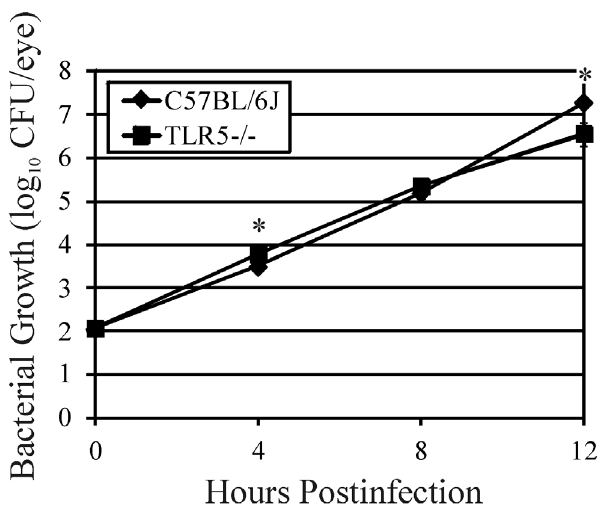
Figure 1. Influence of TLR5 on bacterial growth during experimental B.cereus endophthalmitis. C57BL/6J wild type and TLR5 2 / 2 mouse eyes were injected with 100 CFU B. cereus . Eyes were harvested, homogenized, and analyzed for bacterial growth. Overall, B. cereus grew to similar concentrations in infected eyes of TLR5 2 / 2 and C57BL/6J mice, suggesting that the absence of TLR5 did not influence the overall growth of B. cereus in the eye. Values represent the mean log 10 CFU 6 SD of N $ 4 eyes per time point for at least 2 separate experiments. *P #